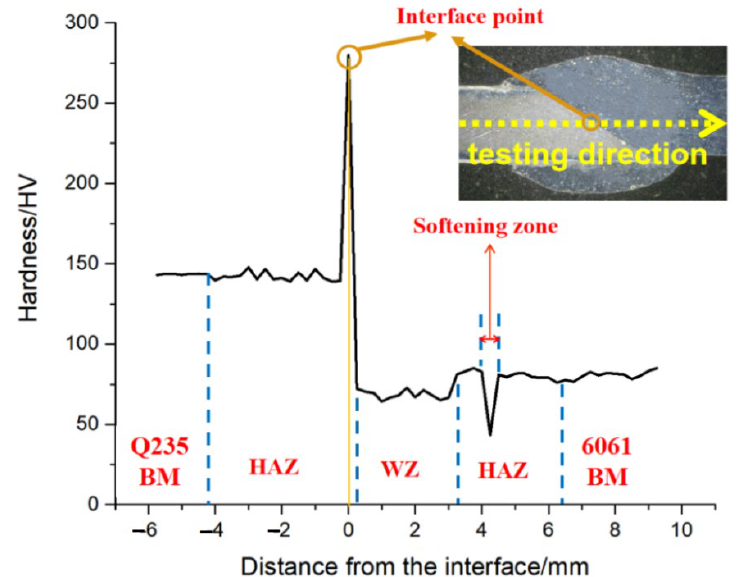
Figure 9. Microhardness of welded joint .